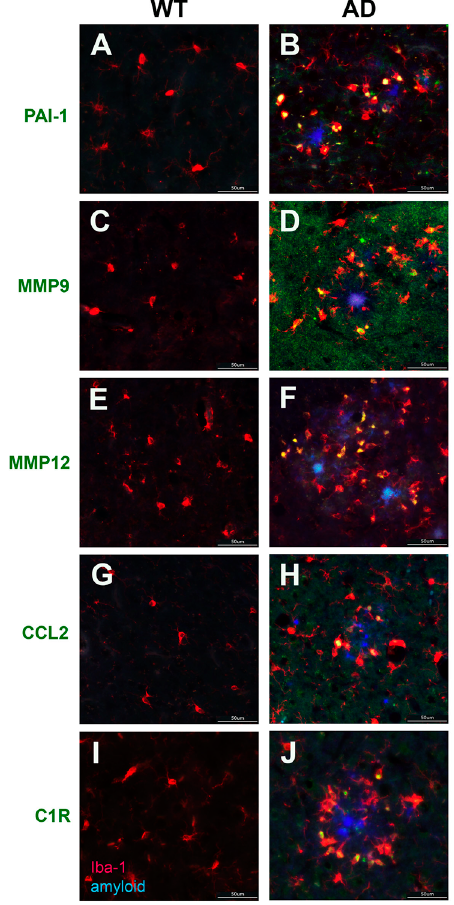
Figure 7. Validation of A β 42 fibril-induced microglia genes by immunolabeling. Increased im- munolabeling for PAI-1, MMP9, MMP12, CCL2, and C1R co-localized with microglia surrounding amyloid plaques. Brain sections from 15 M WT rats ( A , C , E , G , I ) and F344Tg-AD rats ( B , D , F , H , J ) were labeled with mAb66.1 to detect amyloid plaques (blue) and goat polyclonal antibody to Iba1 for microglia (red), as well as rabbit polyclonal antibodies to PAI-1, MMP9, MMP12, CCL2, and C1R (green). Scale bars = 50 µm.